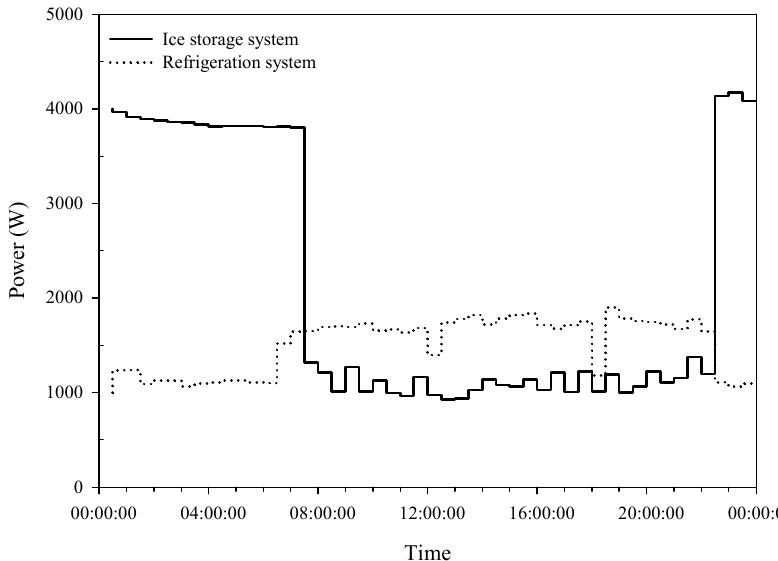
Figure 9. Comparison between the power consumption of the two systems.